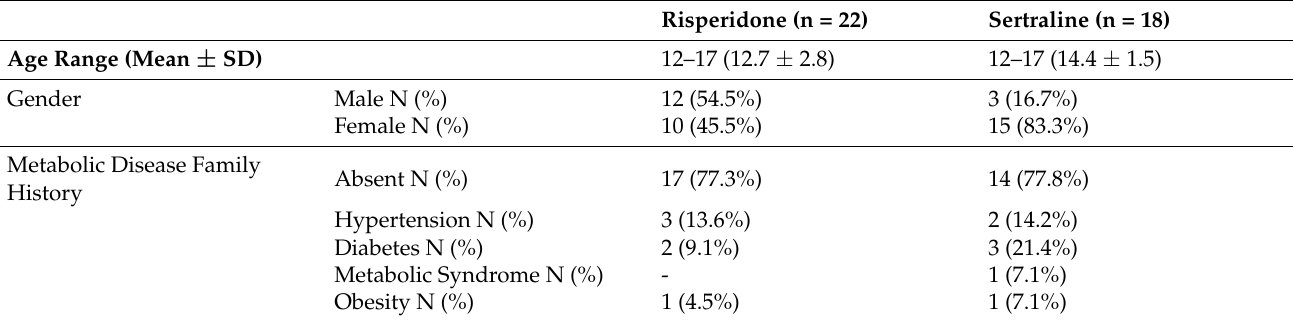
Table 1. Sociodemographic and clinical data of both